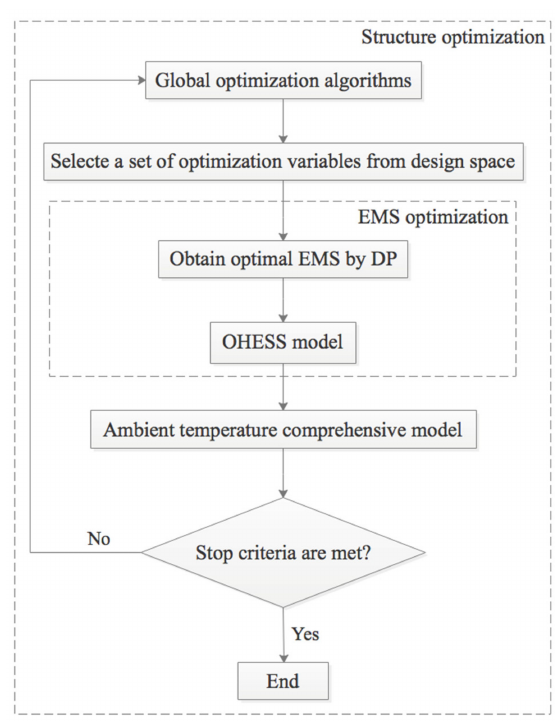
Figure 21. Flow chart of the nested